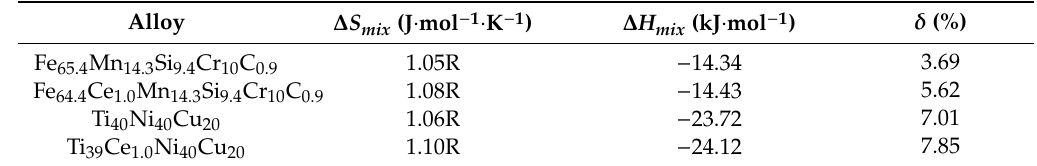
Table 2. ∆ S mix and ∆ H mix of TRIP BMGCs.